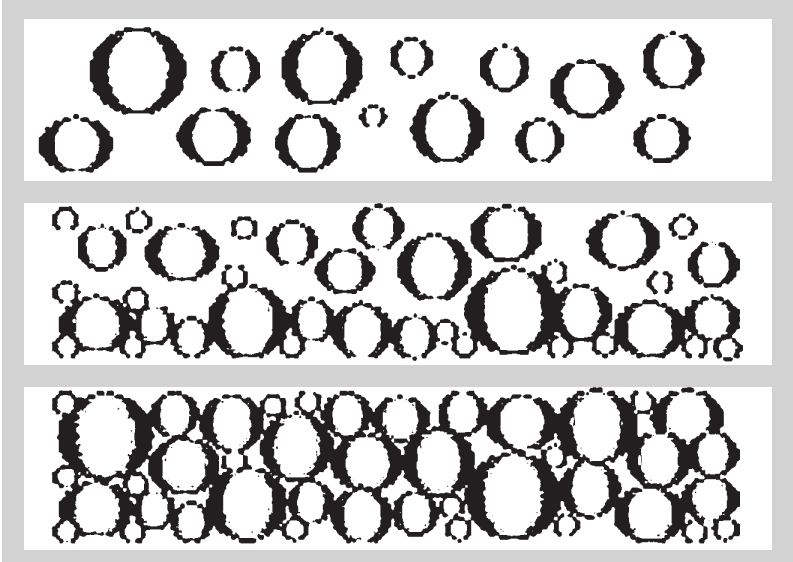
Figure 1 (above): Super- saturated sample with Vl >> Vs. Figure 2 (middle): The start of filter cake formation. Figure 3 (below): Immobilized sample with S =